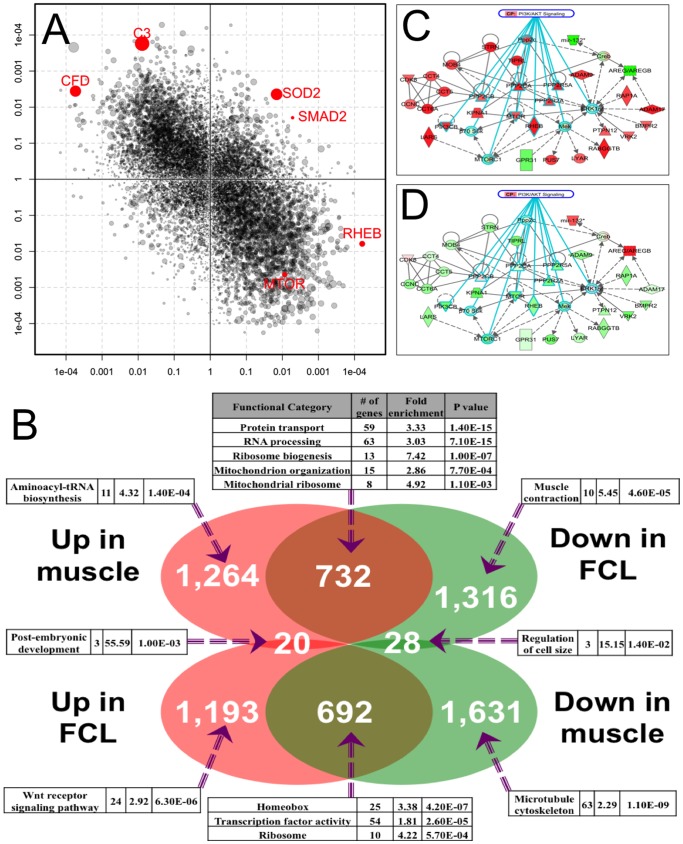
The global pattern of transcriptome changes in RC disease was reversed in muscle and FCL.(A) The global pattern of differential gene expression showed a highly significant negative correlation between RC disease muscle and FCLs (r = −0.49, p<10−16). The x- and y-axis units are signed p values, where dot size of individual genes is proportional to the combined fold-change of the two tissue types in RC disease relative to controls. (B) Genes were categorized based on their relative differential expression patterns in both muscle and FCL RC disease. Each subset was submitted to DAVID for over-representation analysis, where the most significant categories identified in DAVID are detailed for each of 8 unique gene subsets. (C–D) One of the spontaneously constructed IPA gene networks centered on MTOR. Red and green convey up- and down-regulation in RC disease, respectively. Twelve of the genes in this network have previously been associated to PI3K/AKT pathway signaling (blue lines). (C) Most genes in the MTOR IPA gene network showed significant up-regulation in RC disease muscle, with the exception of only a few downstream network members, such as mir-132. (D) Almost all genes identified in the IPA-centered MTOR network showed reversed expression change in RC disease FCL relative to controls as had been seen in muscle, including mir-132 (Fig. 4C).